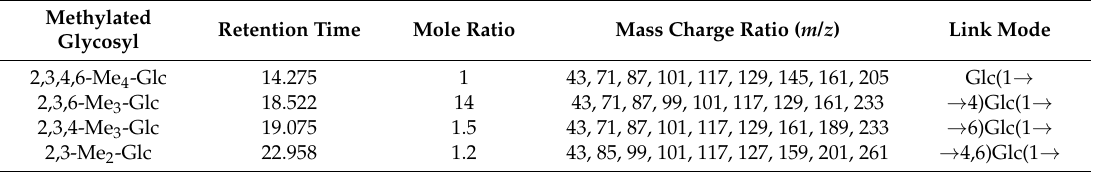
Table 1. The methylation reaction results of H-1-2.